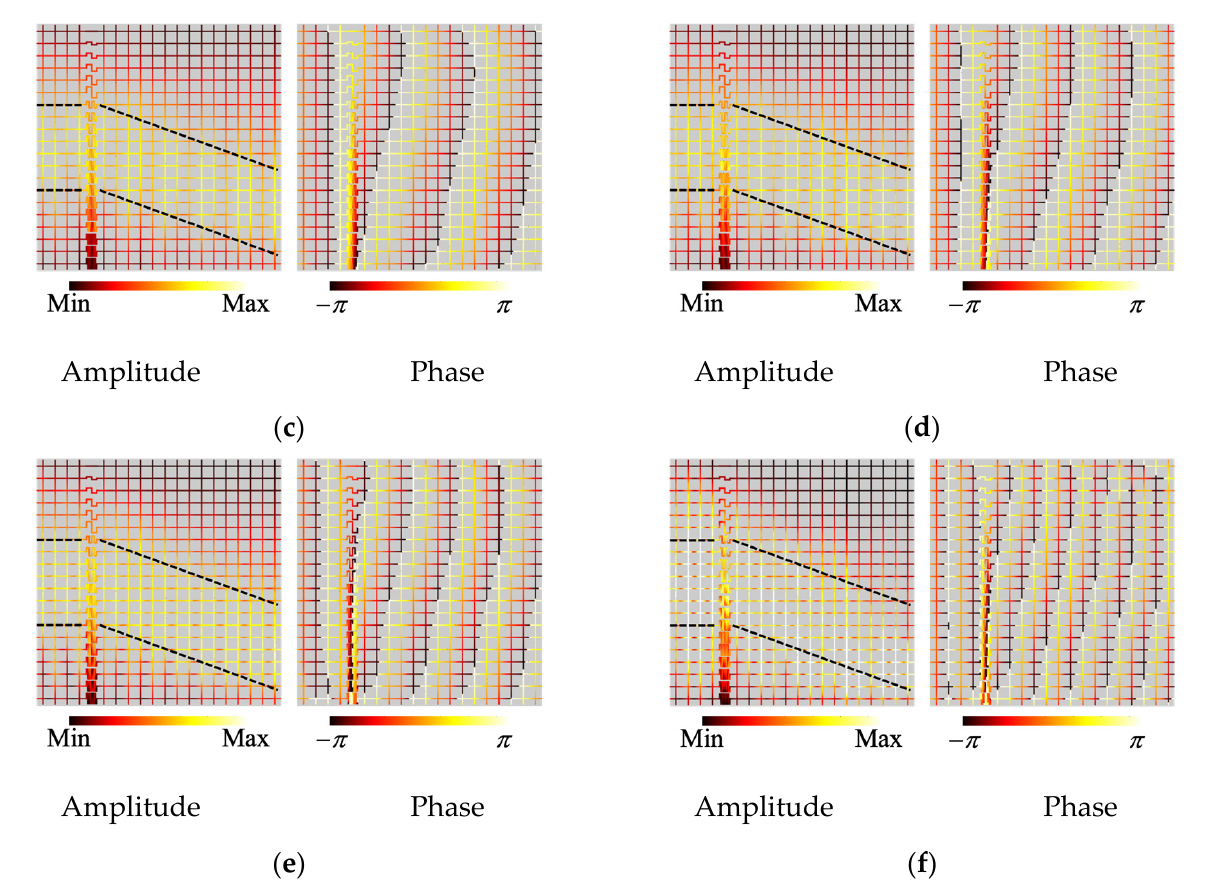
Figure 9. Complex sound pressure distributions for the acoustic metasurface: ( a ) 3.063 kHz ( λ = 8 ∆ d = 80 mm); ( b ) 3.500 kHz ( λ = 7 ∆ d = 70 mm); ( c ) 4.084 kHz ( λ = 6 ∆ d = 60 mm); ( d ) 4.900 kHz ( λ = 5 ∆ d = 50 mm); ( e ) 6.125 kHz ( λ = 4 ∆ d = 40 mm); ( f ) 8.167 kHz ( λ = 3 ∆ d = 30 mm). The left and right figures present the amplitude and phase, respectively. Incident plane waves illuminate the acoustic metasurface perpendicularly from the left-hand side of the analysis area and are refracted by that. The broken lines represent the theoretical propagation direction of incident and refracted waves.